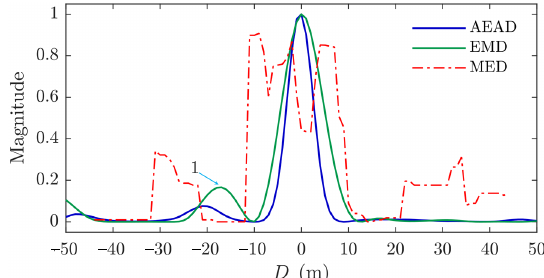
Figure 8. Experiment results of different